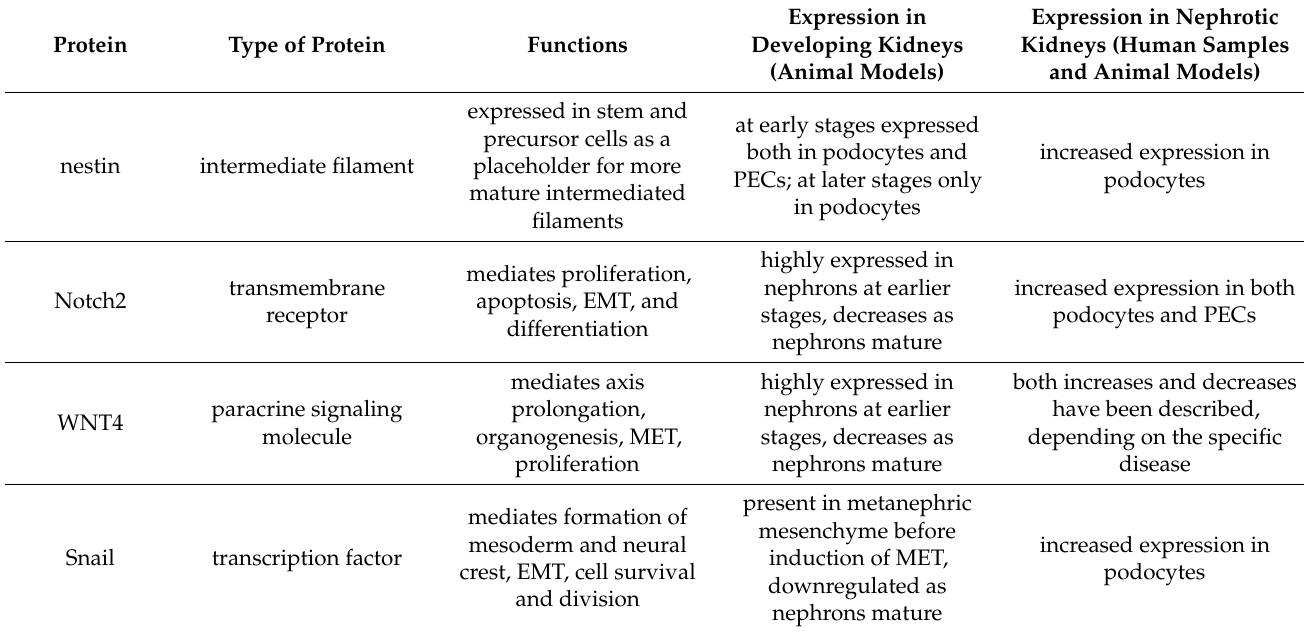
Table 1. Existing information about the analyzed